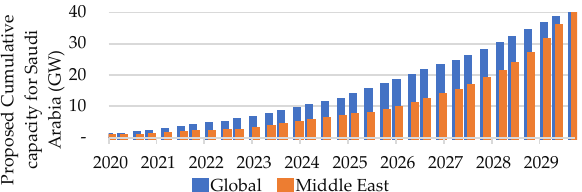
Figure 11. Saudi deployment rate proposal based on global and Middle East historical trend. Since the Middle East deployment rate is significantly lower in the initial years and the increment is exponential towards the end of deployment period, the inventory time became high, which is reflected in the cost of inventory. On the other hand, the global trend follows a smoother trend line, which resulted in less inventory waiting time, and hence, less inventory cost. Figure 12 below shows the level of inventory time following global and Middle East PV deployment trends modelling.